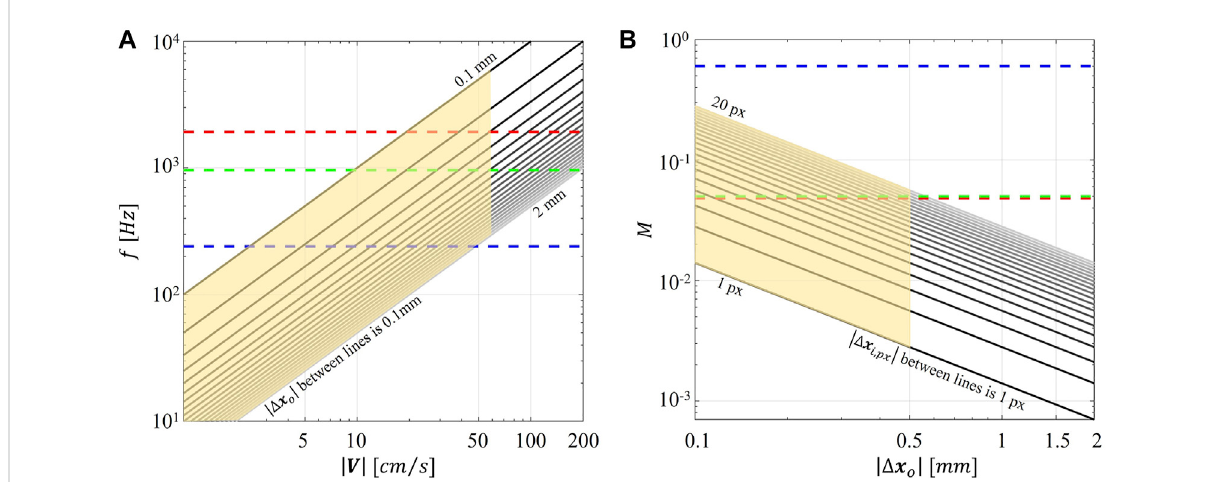
FIGURE 1 (A) Magnitude of particle displacement in the object plane ( | Δ x o | ) depending on the magnitude of fl ow velocity ( | V | ) and the acquisition frequency ( f ), assuming pixel sizes of 1.4 μ m, typical of current smartphone cameras. (B) Magnitude of particle displacement in the image plane ( | Δ x i , px | )dependingonthemagnitudeoftheparticledisplacementintheobjectplane( | Δ x o | )andthemagni fi cationfactor( M ),assumingapixelsizeof 1.4 μ m. Dashed lines correspond to the Huawei Mate Pro 30 (red dotted line), the Samsung Galaxy S9+ (green dotted line), used in the present work, and the iPhone 13 Pro (blue dotted line). The highlighted area represents the measurement feasibility range in the smart-PIV con fi guration.